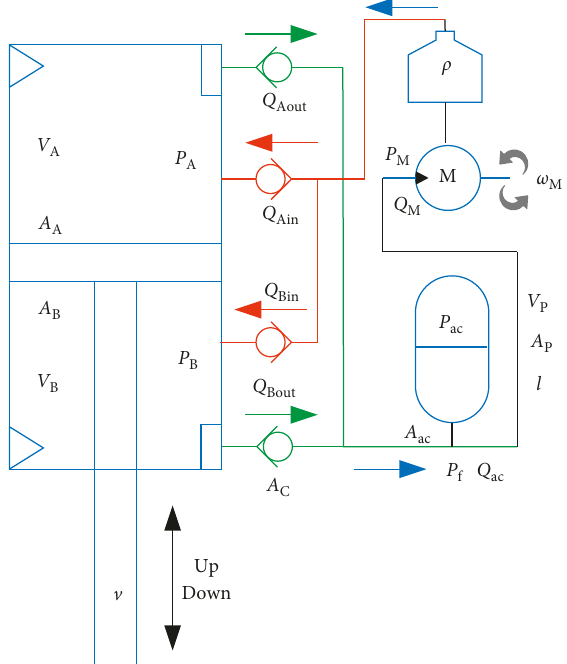
Figure 3: Schematic view of fluid flows in hydraulic